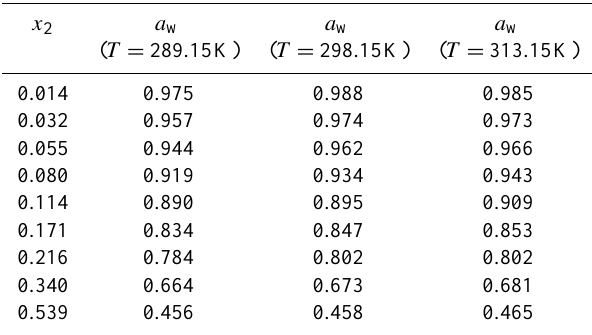
Table A3. Bulk water activity (a w ) measurements a of water (1) + 1,2,6-hexanetriol (2) solutions at three different temperatures. Solution compositions are given in mole fraction of the organic component (2), x 2 . x 2 a